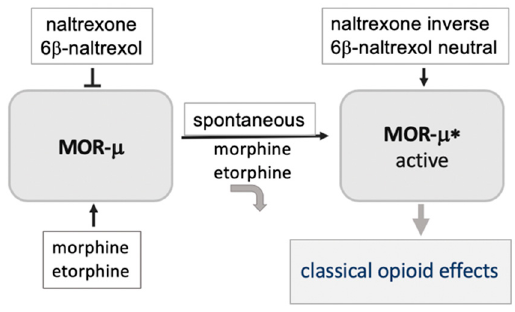
Figure 1. Model of the µ opioid receptor, invoking a silent ground state MOR- µ and a ligand-free activated state µ opioid receptor (MOR)- µ *. Most opioid agonists have low affinity for MOR- µ *, and therefore, dissociate from the receptor, with MOR- µ * responsible for the signaling process. The antagonists naltrexone and 6b-naltrexol (6BN) are proposed to have high affinity for both MOR- µ and MOR- µ *, blocking agonist-mediated activation of MOR- µ in a competitive fashion. Naltrexone potently blocks MOR- µ * activity as an inverse agonist, whereas the neutral antagonist 6BN binds to MOR- µ * but does not prevent signaling—both acting in a non-competitive fashion at the ligand-free MOR- µ .